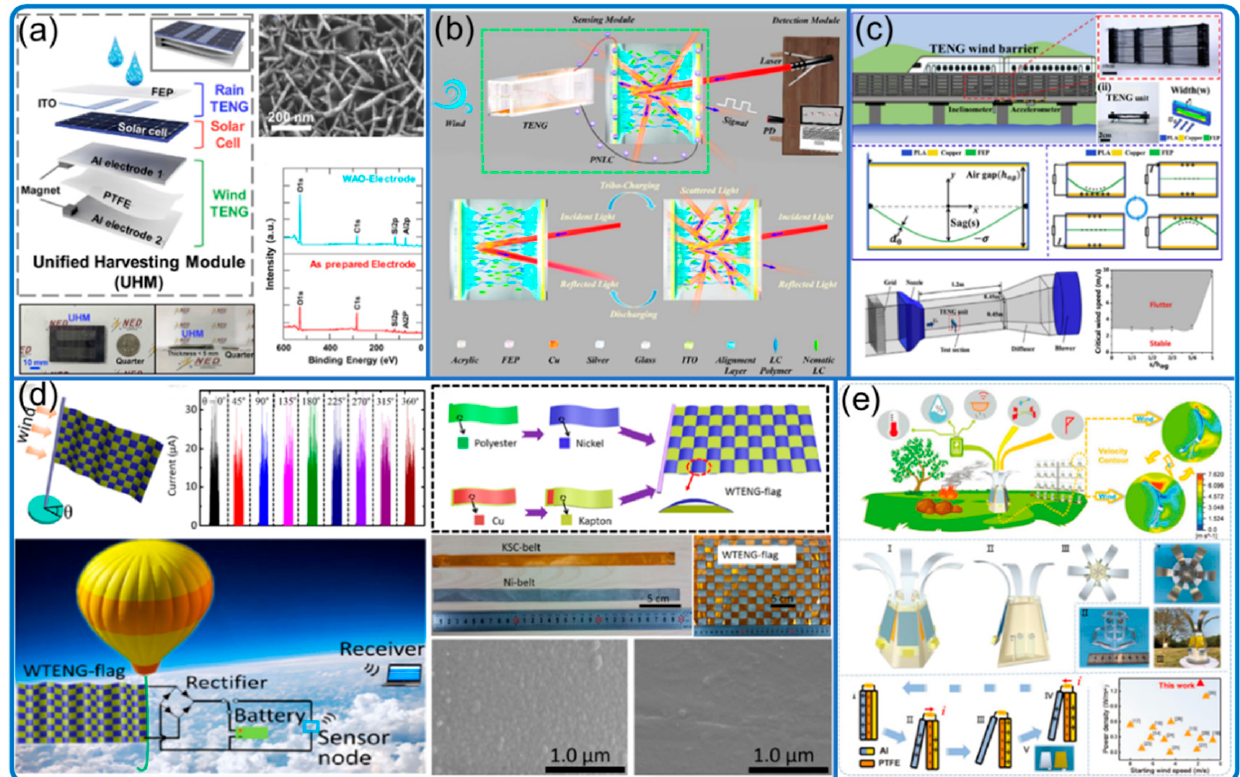
Figure 6. Flutter sensors’ special functions and features. ( a ) Weather monitoring system. Repro-